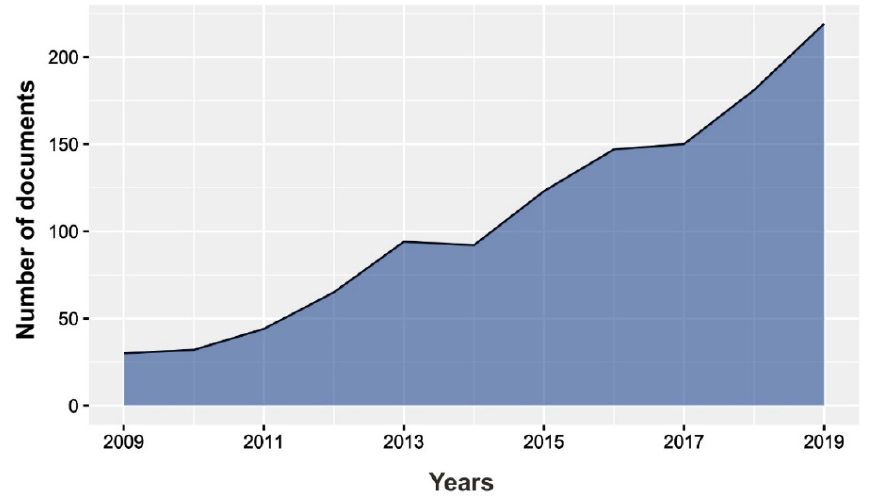
Figure 1. Evolution of the number of publications from 2009 to 2019 in the field of pigments from microalgae.